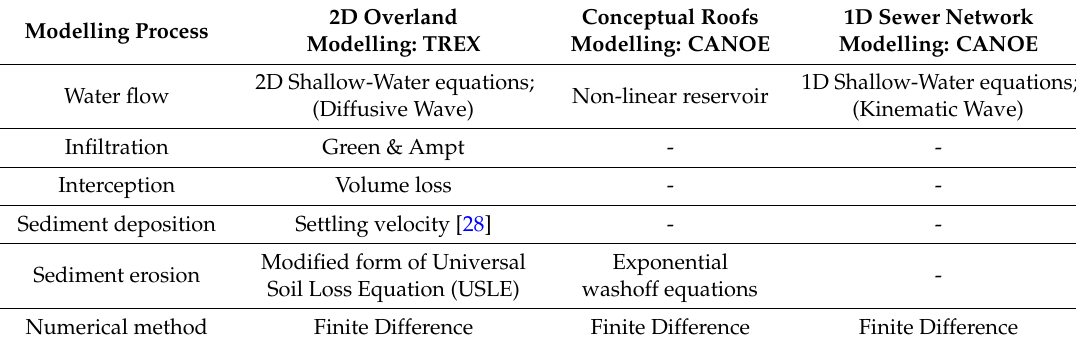
Table 1. Modelling processes in the 2D/1D TRENOE platform.